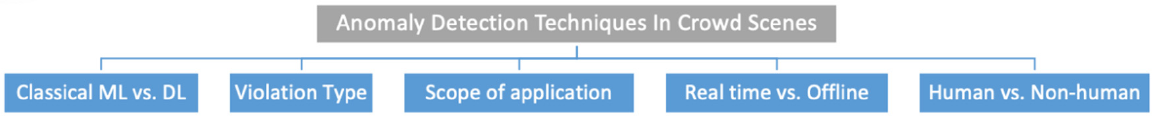
Figure 4. Anomaly detection techniques in crowd scenes.